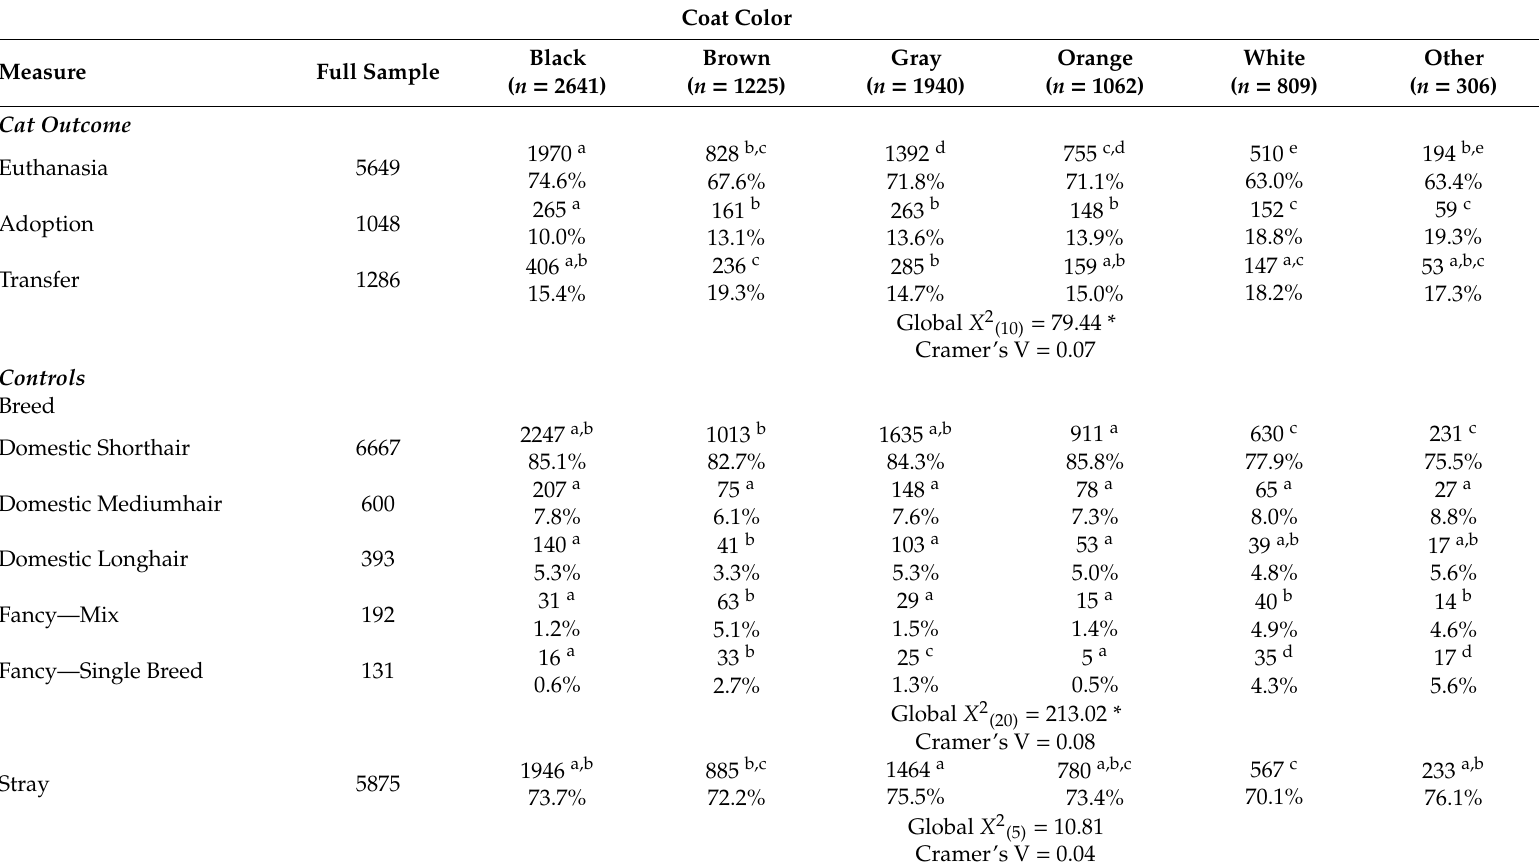
Table 1. Contingency Tables for Coat Color by Cat Outcome and for Coat Color by Controls ( n =